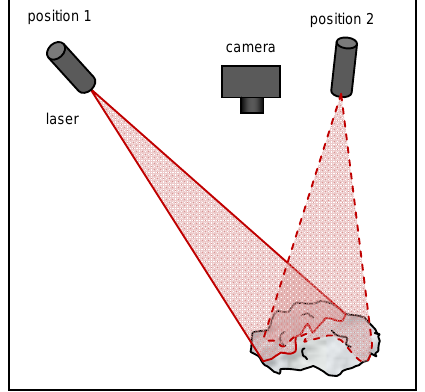
Figure 7: System layout with different illumination directions of the laser line